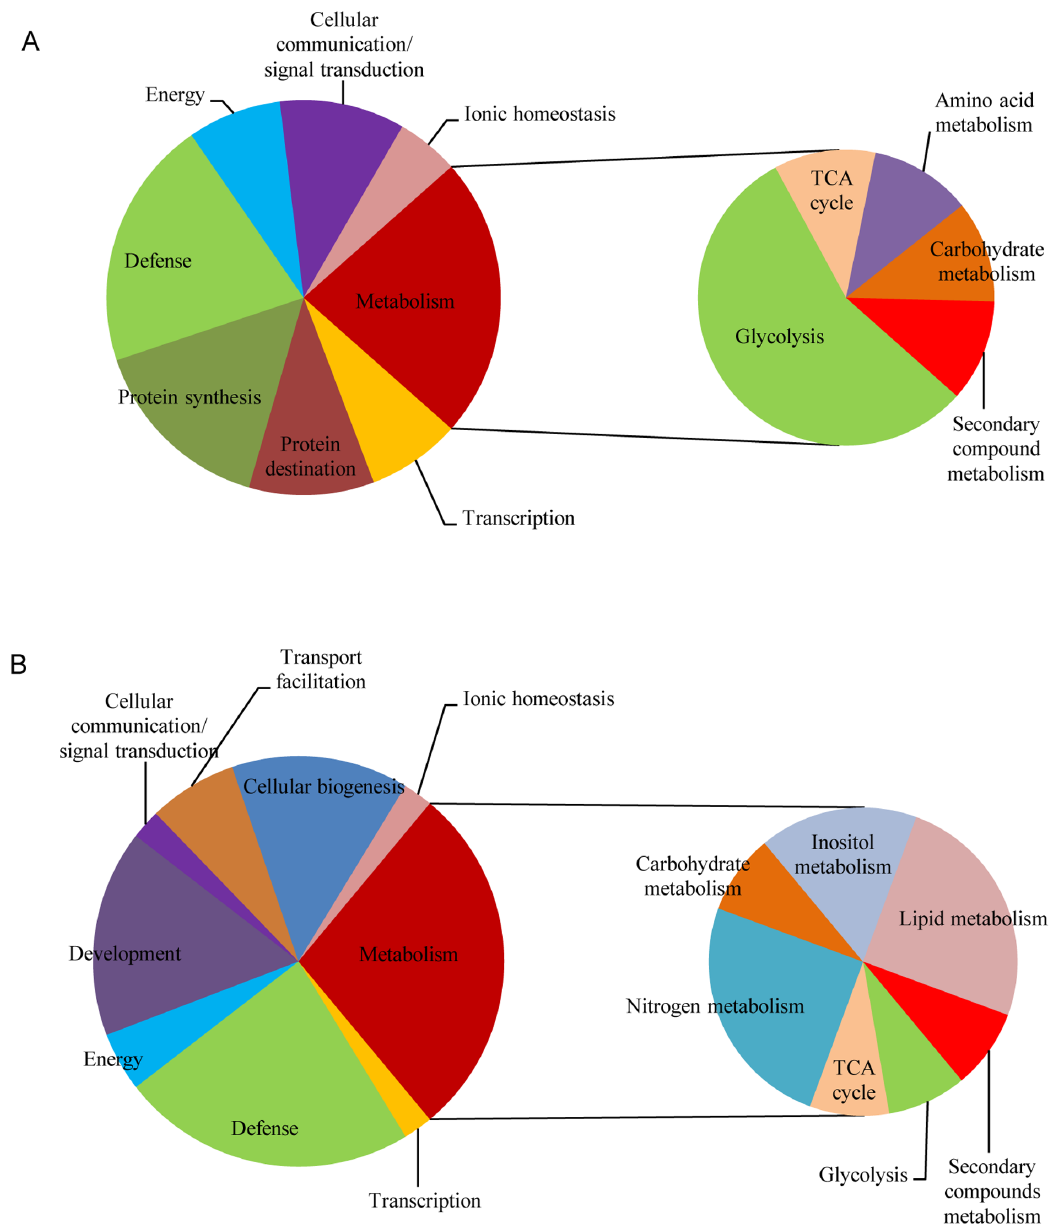
Figure 3. Functional category of the labeled proteins in 2-D maps of the three maize hybrids studied. A: the protein category in the endosperm; B: the protein category in the